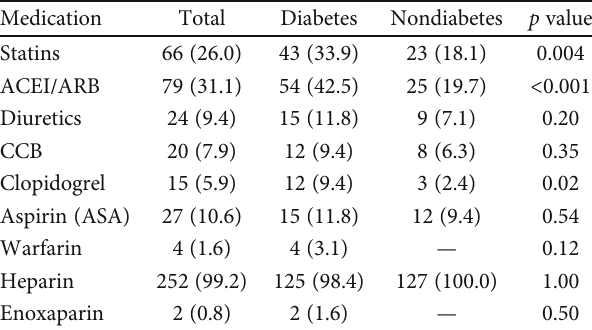
Table 2: Medications used by patients during hospitalization.